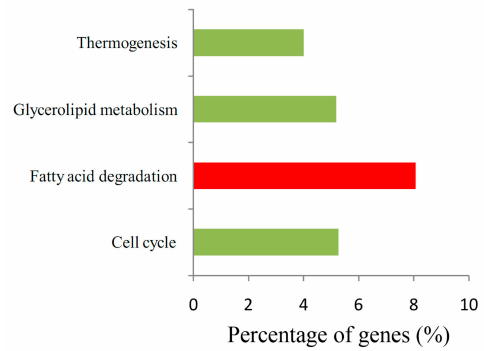
Figure 6. KEGG (Kyoto Encyclopedia of Genes and Genomes) pathway enrichment of the target genes of DEMs. The axis X the percentage of enriched target genes to all genes in this pathway. The red bar represents the pathway that was controlled by down-regulated